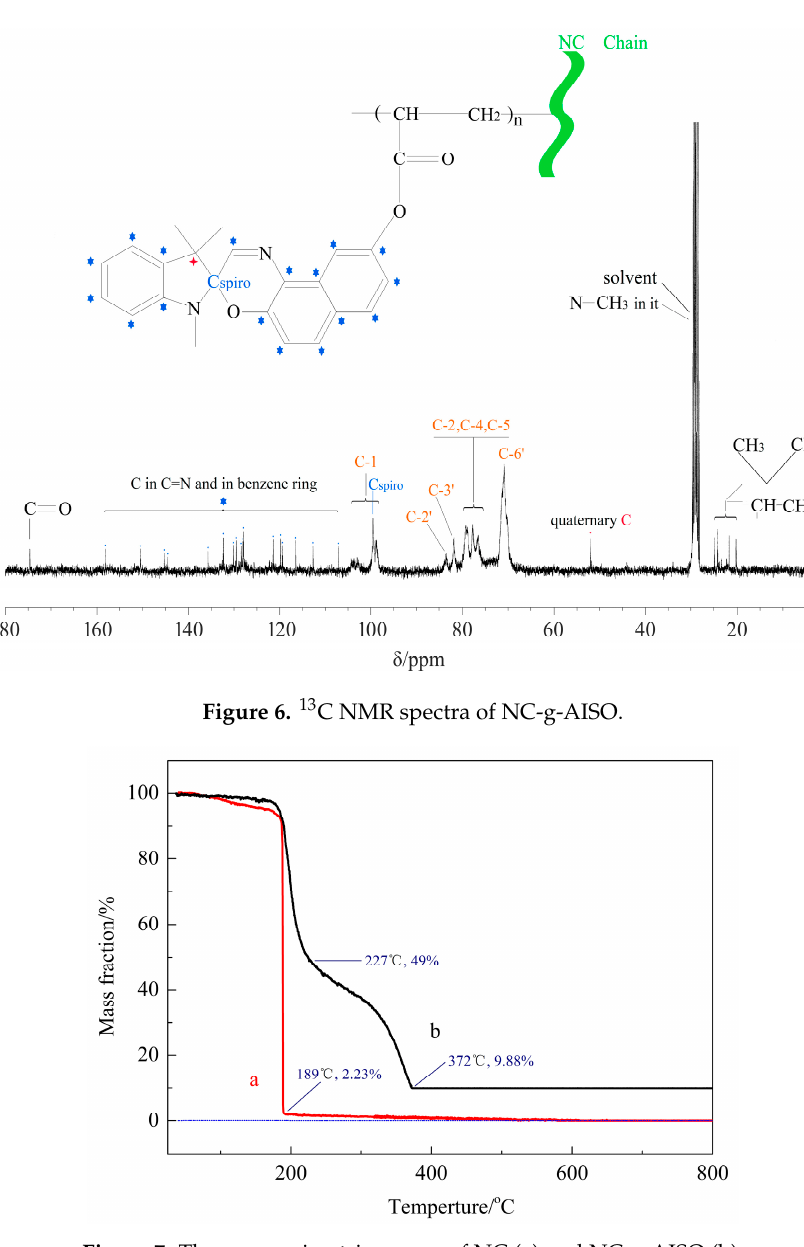
Figure 7. Thermogravimetric curves of NC (a) and NC-g-AISO (b).